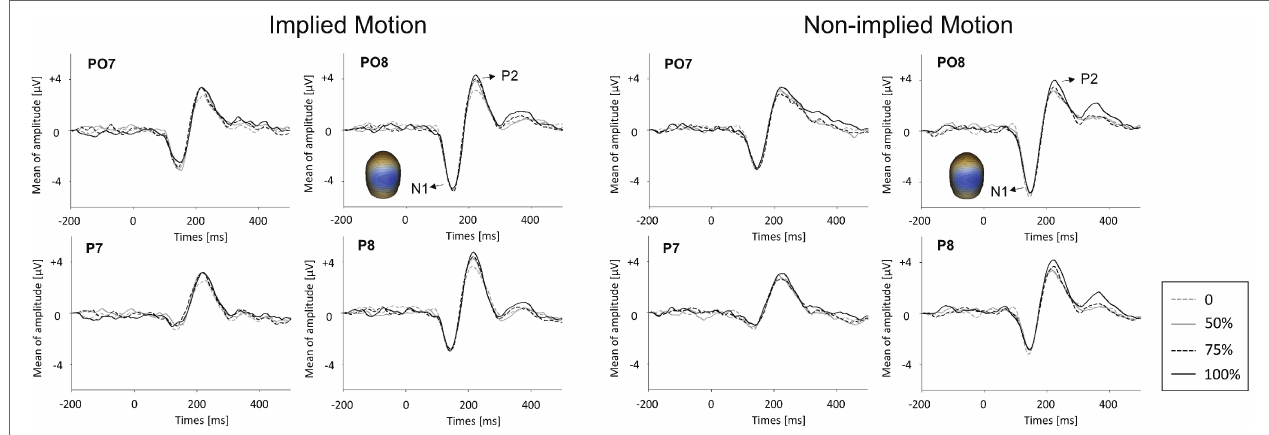
FIGURE 2 | Event-related potential waveforms for implied motion (IM) pictures and non-implied motion (non-IM) pictures at different coherence levels. Two visual event-related potentials, N1 and P2, were identified. The global field power (GFP) plots are based on peak amplitudes. Averaged topographic maps of the N1 component (100–170 ms) in IM condition and non-IM condition are also